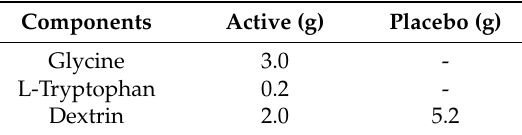
Table 1. Components of the test